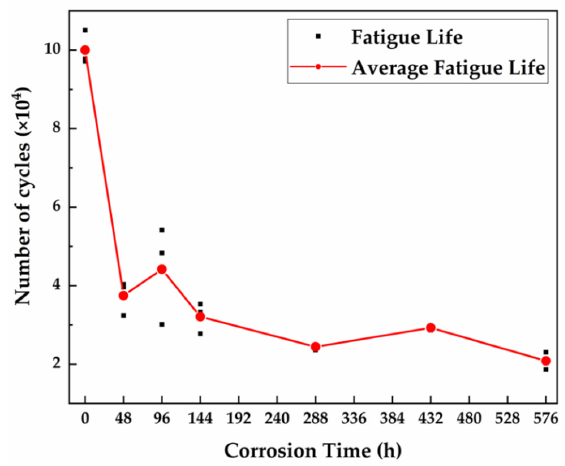
Figure 9. Fatigue life of 30CrMnSiA steel after the 576-h alternate immersion test.